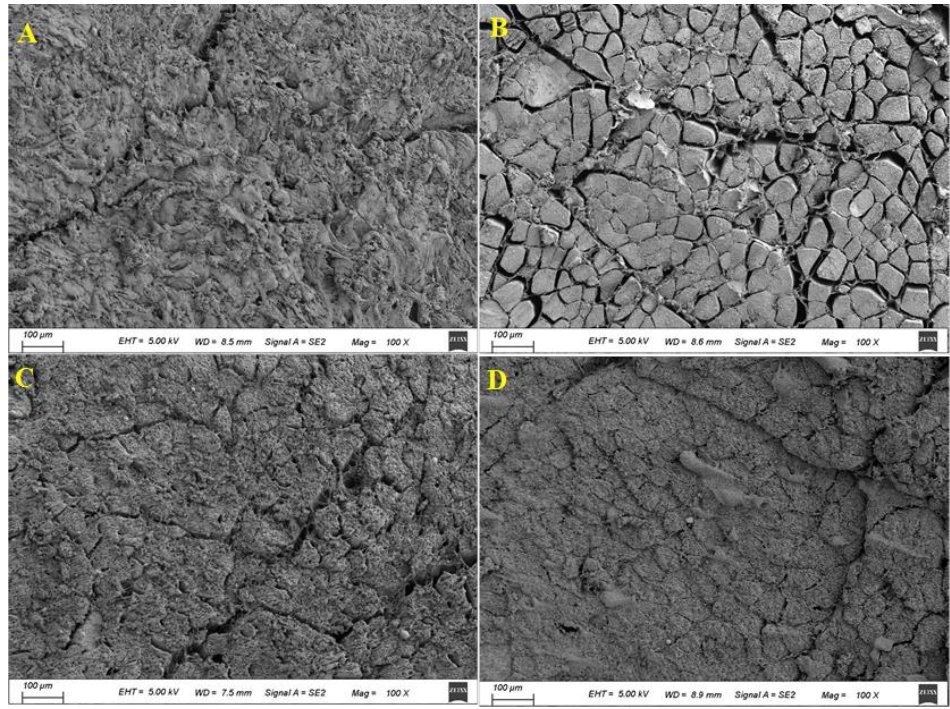
Figure 6. Microstructure of fresh pork ( A ) and pork stored in the control group ( B ), CS coating group ( C ) and ferulic acid-g-CS coating group ( D ) at 4 °C for 8 days.